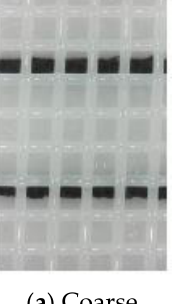
Figure 1. Samples of the two wire mesh screens used in the bubble point test; ( a ) coarse and ( b ) fine. The black bars in the background belong to a millimeter scale.